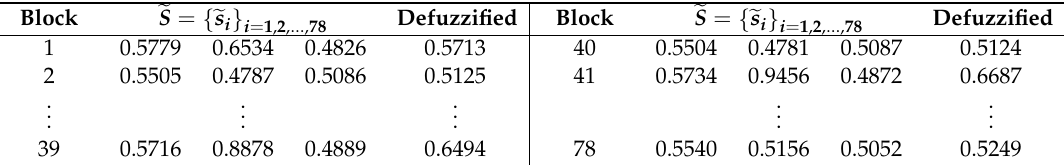
Table 7. The relative closeness of the matrix (78 × 6).